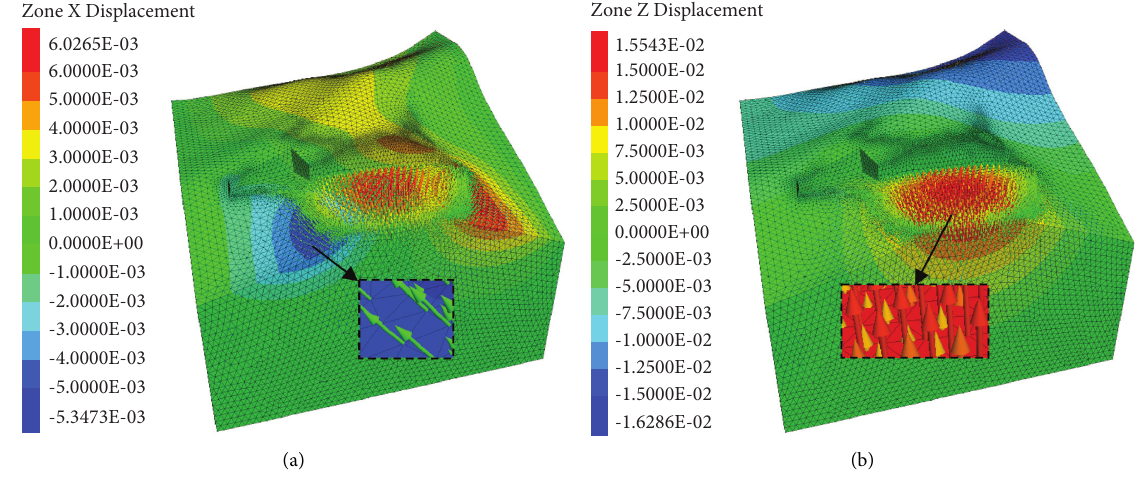
Figure 10: Strain nephogram after second excavation. (a) X -direction strain nephogram and (b) Z -direction strain